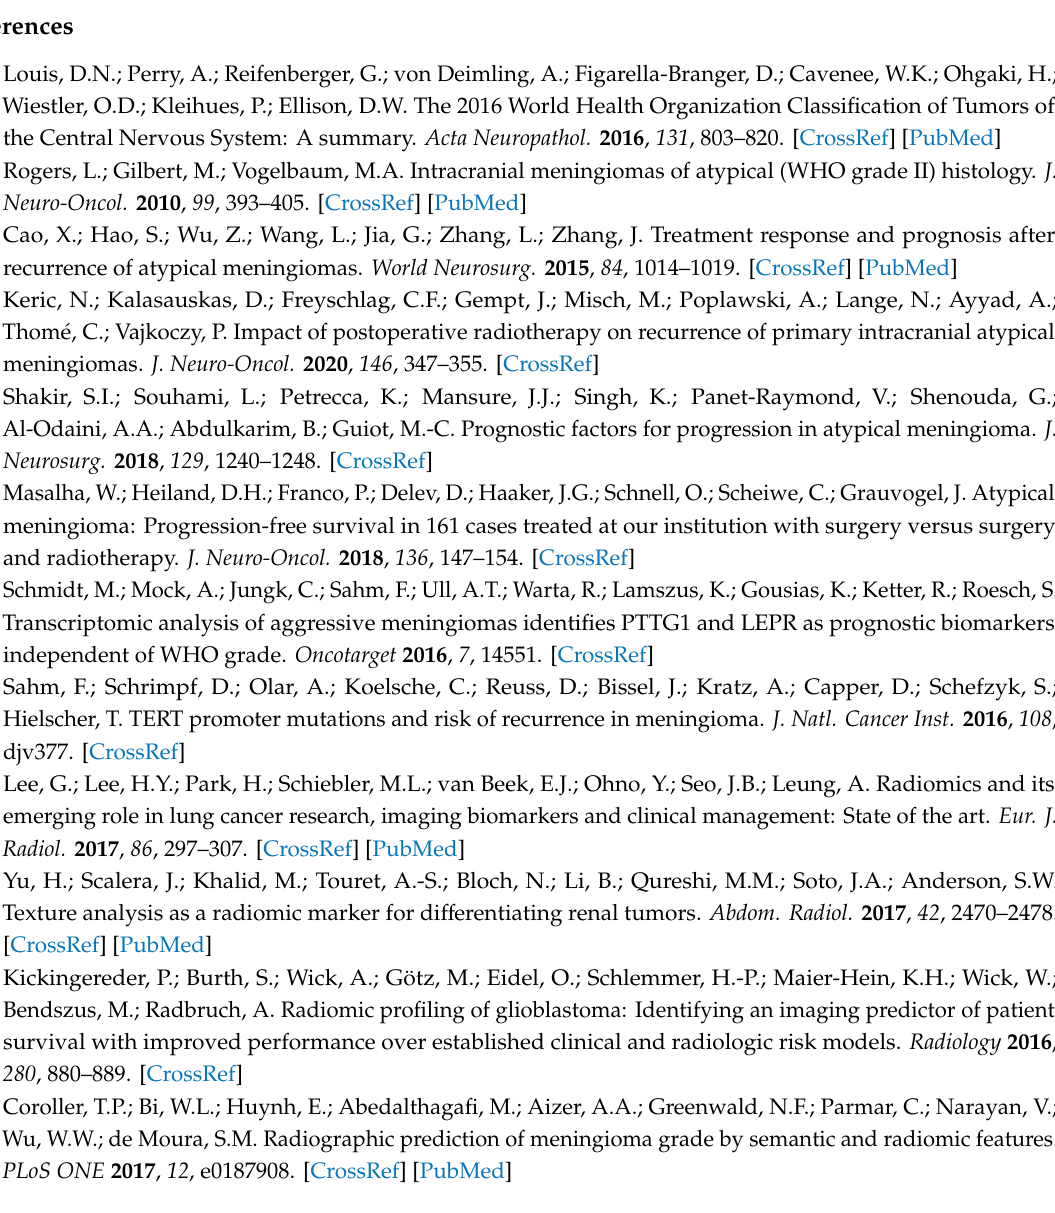
Table S1: Description of radiomic and semantic features used in tumor